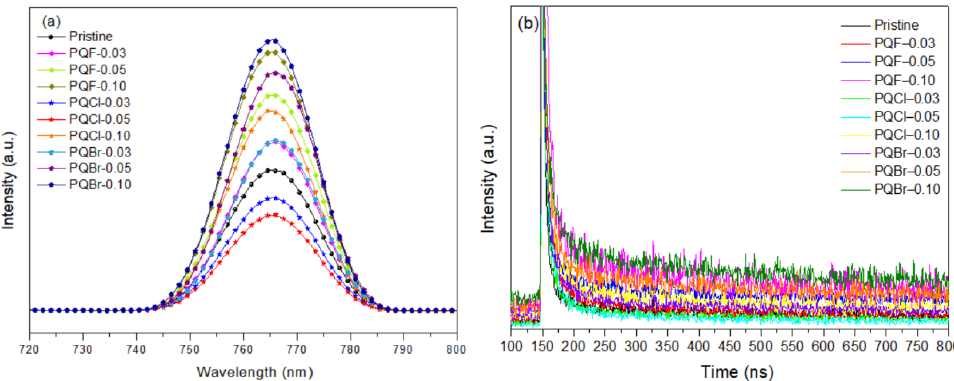
Figure 10. ( a ) PL and ( b ) TRPL spectra of MAPbI 3 films deposited on cellulose derivative–modified NiO x layers (Excitation wavelength: 765 nm). Table 2. Fitted parameters of the TRPL spectra of MAPbI 3 films coated on cellulose derivative–mod- ified NiO x layers coated on FTO glass.